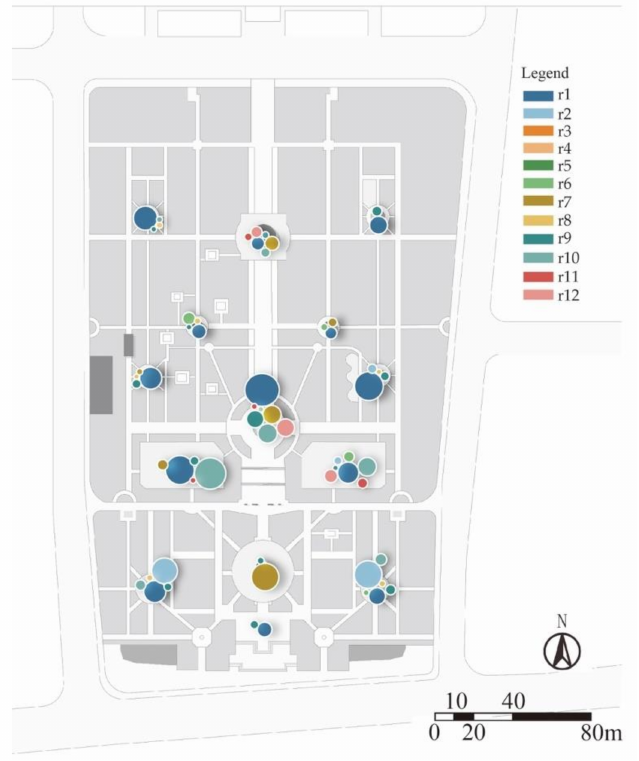
Figure A7. Spatial distribution of various recreational activity users in Renmin Park.